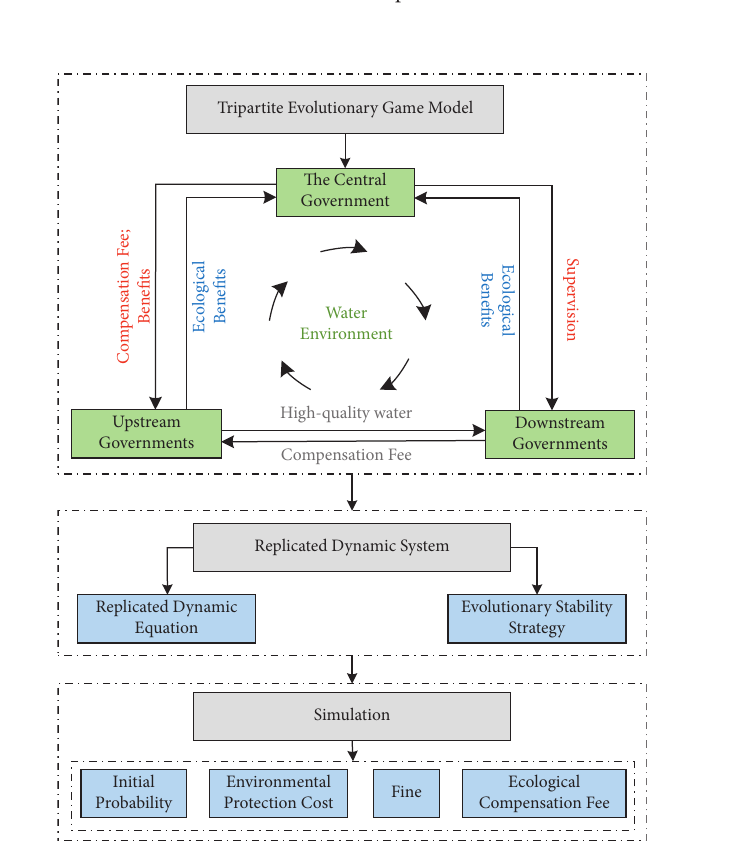
Figure 1: Game process.